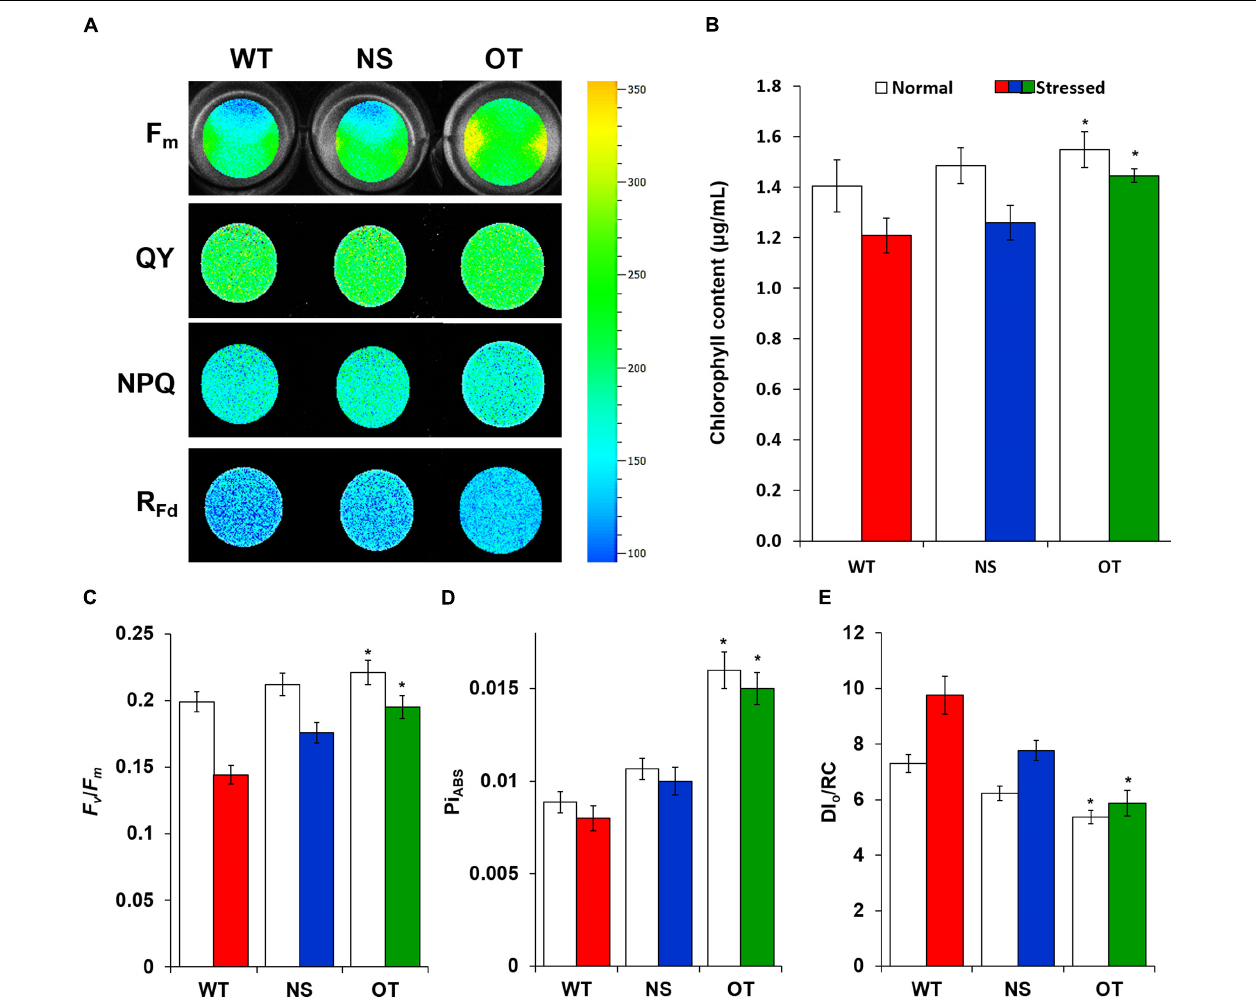
FIGURE 6 | Comparison of chlorophyll fluorescence in cyanobacterial cells grown under normal and H 2 O 2 stress conditions. (A) Fluorescence images of F m , QY, NPQ, and R Fd in WT, NS, and OT strains. The higher efficiency rates are depicted in red and the lower rates in blue. (B) Chlorophyll content, (C) F v / F m , (D) Pi ABS , and (E) DI 0 /RC. F m , maximum fluorescence; QY, quantum yield of photochemical energy conversion in photosystem II; NPQ, non-photochemical quenching; R Fd , chlorophyll fluorescence decrease ratio; F v / F m , photochemical yield; Pi ABS , performance index for photosynthesis; DI 0 /RC, value of the energy dissipated per reaction center. Error bars indicate ± SD of three independent experiments. Asterisks indicate significant differences between treatments as estimated by Student’s t -test ( P < 0.05).